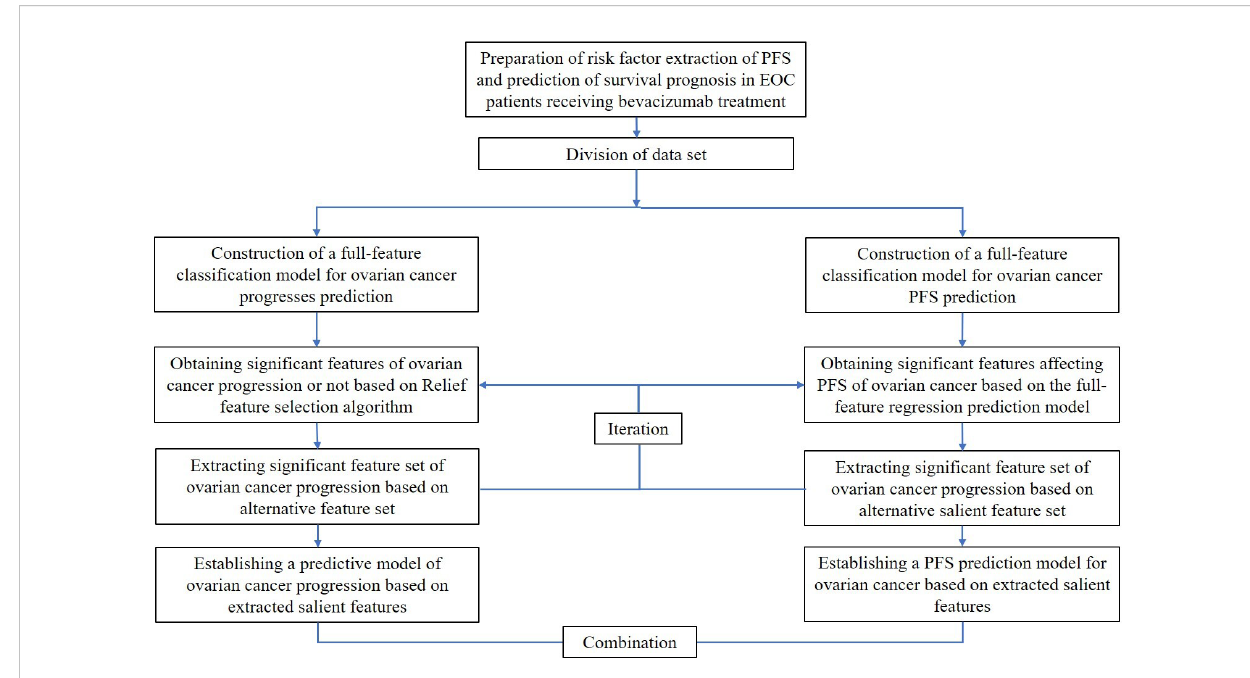
FIGURE 1 The fl owchart of a PFS prediction and risk factors extraction method for EOC patients receiving bevacizumab